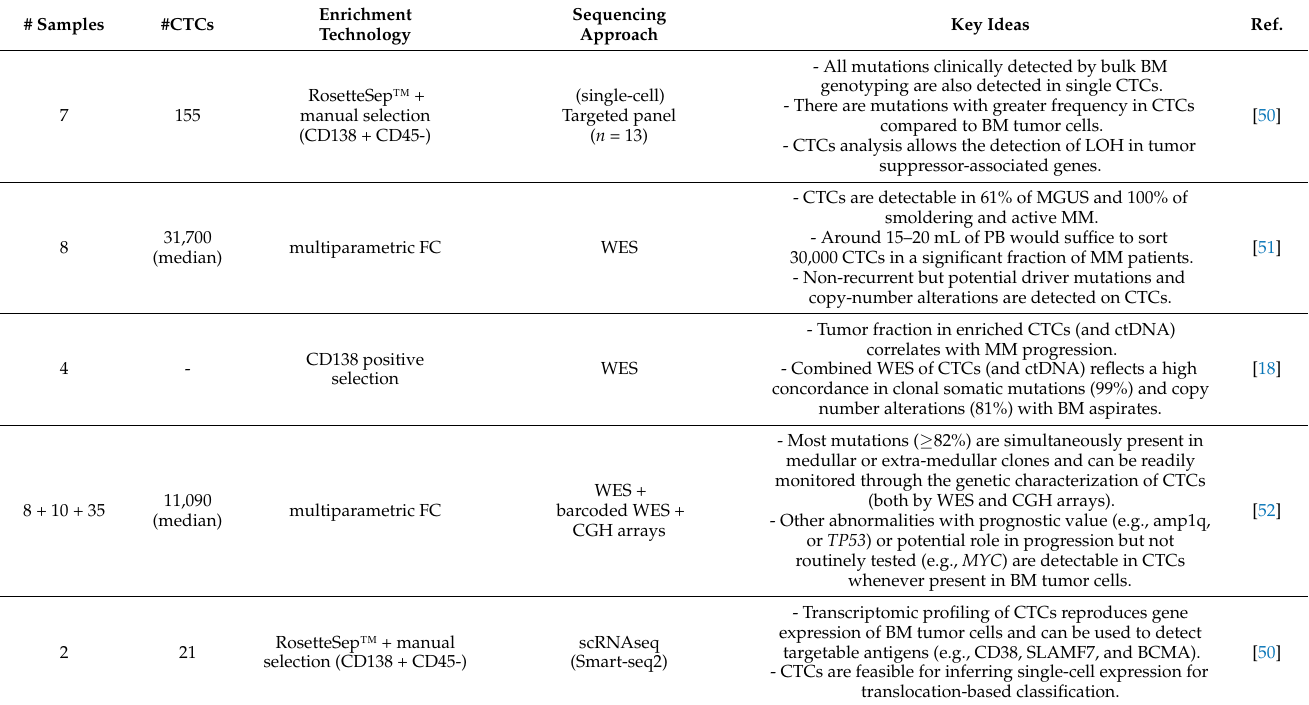
Table 1. Genomic and transcriptomic studies comparing circulating tumor cells (CTCs) vs. bone marrow (BM) tumor cells in multiple myeloma